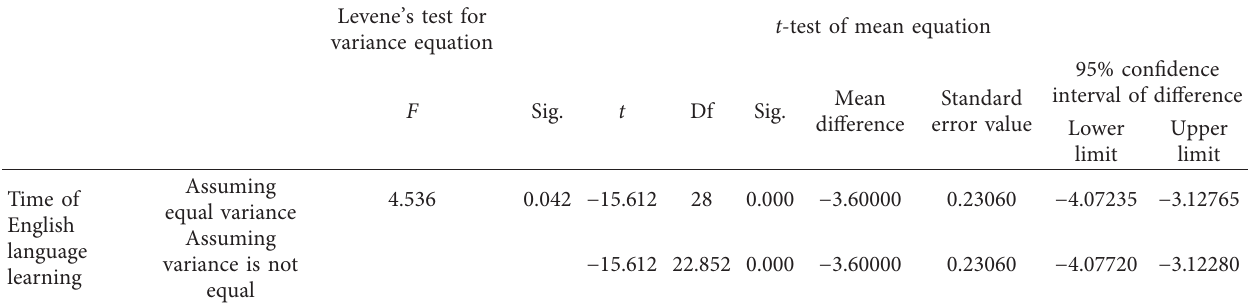
Table 1: The t -test of the